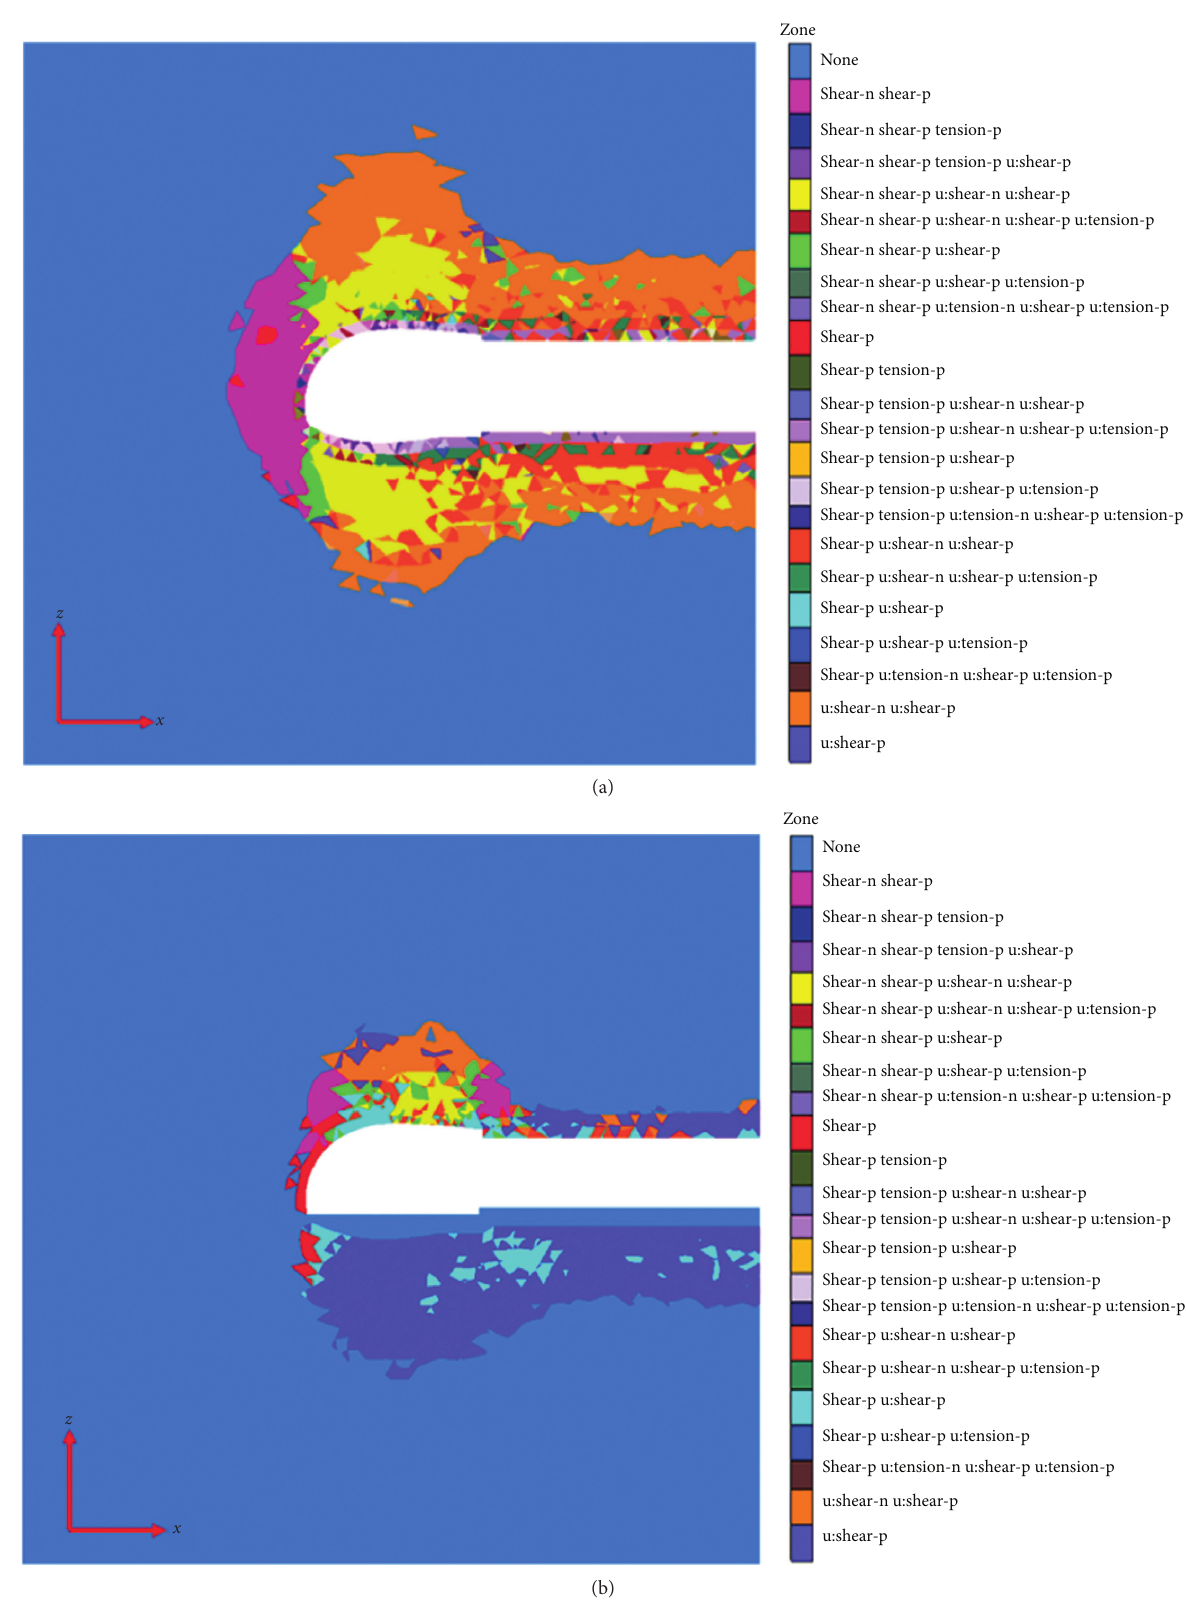
Figure 13: Characteristics of plastic zone. (a) Without support. (b) Prestressed anchor cable